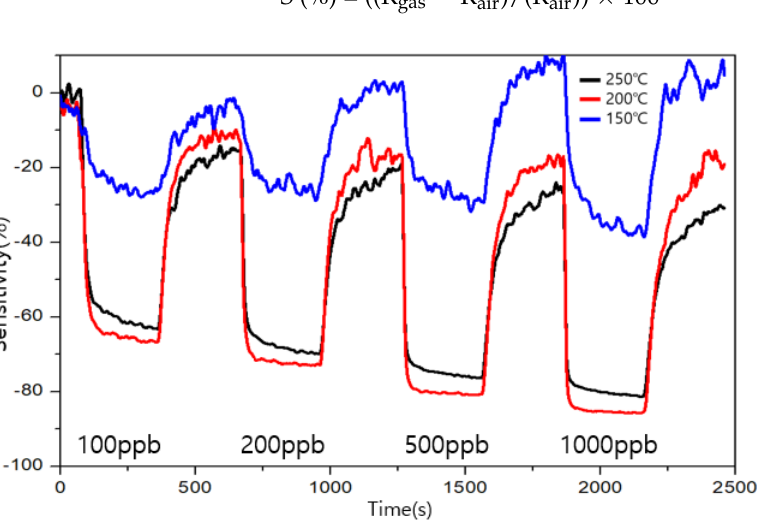
Figure 9. Sensitivity and recovery at different operating temperatures for formaldehyde in the ppb range for the type A sensor.